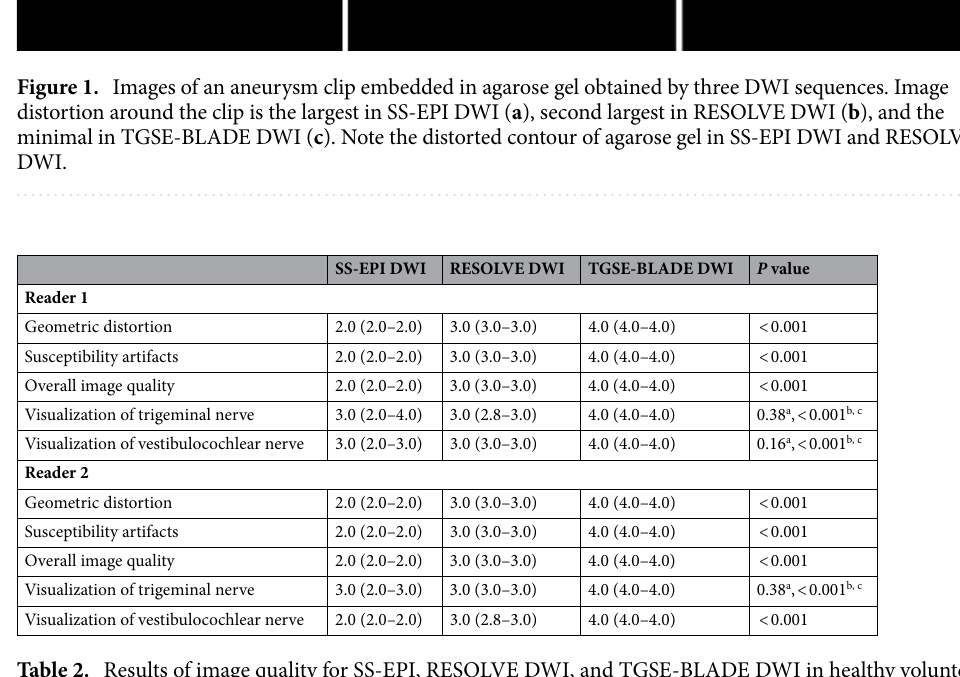
Table 2. Results of image quality for SS-EPI, RESOLVE DWI, and TGSE-BLADE DWI in healthy volunteers. Data are presented as the median (interquartile range) score. a SS-EPI DWI versus RESOLVE DWI; b RESOLVE DWI versus TGSE-BLADE DWI; c SS-EPI DWI versus TGSE-BLADE DWI.